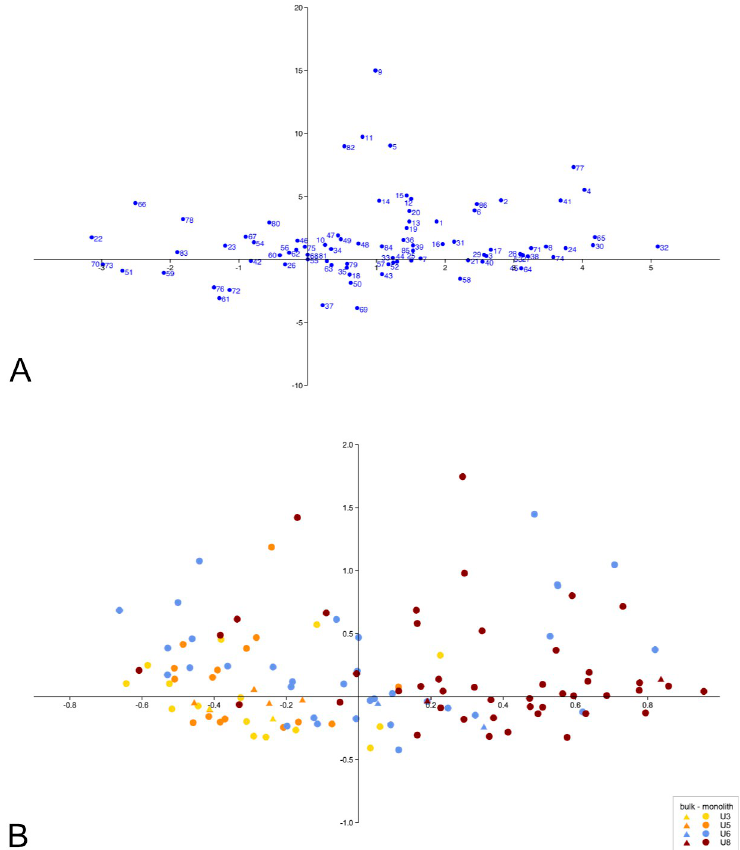
Fig 8. Graph depicting the findings of the Correspondence Analysis based on the values of density of all cultivated and gathered taxa (the first two dimensions are listed, added percentage variation is 32.4%). A: Columns (numbers equate with taxa, see S4 Table for Scientific names, types of remains and preservation); B: Rows (triangles = bulk samples; circles = monolith